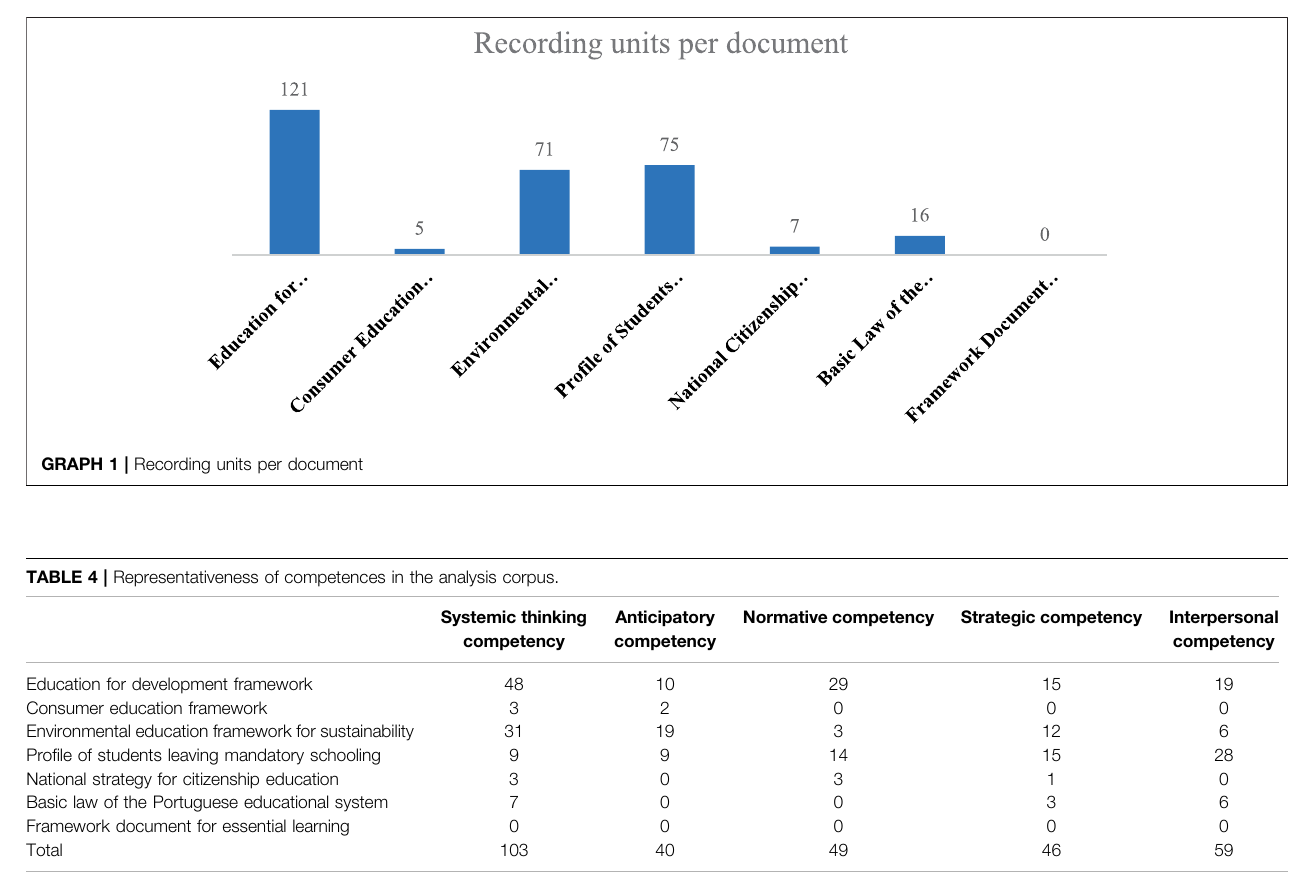
Systemic thinking competency